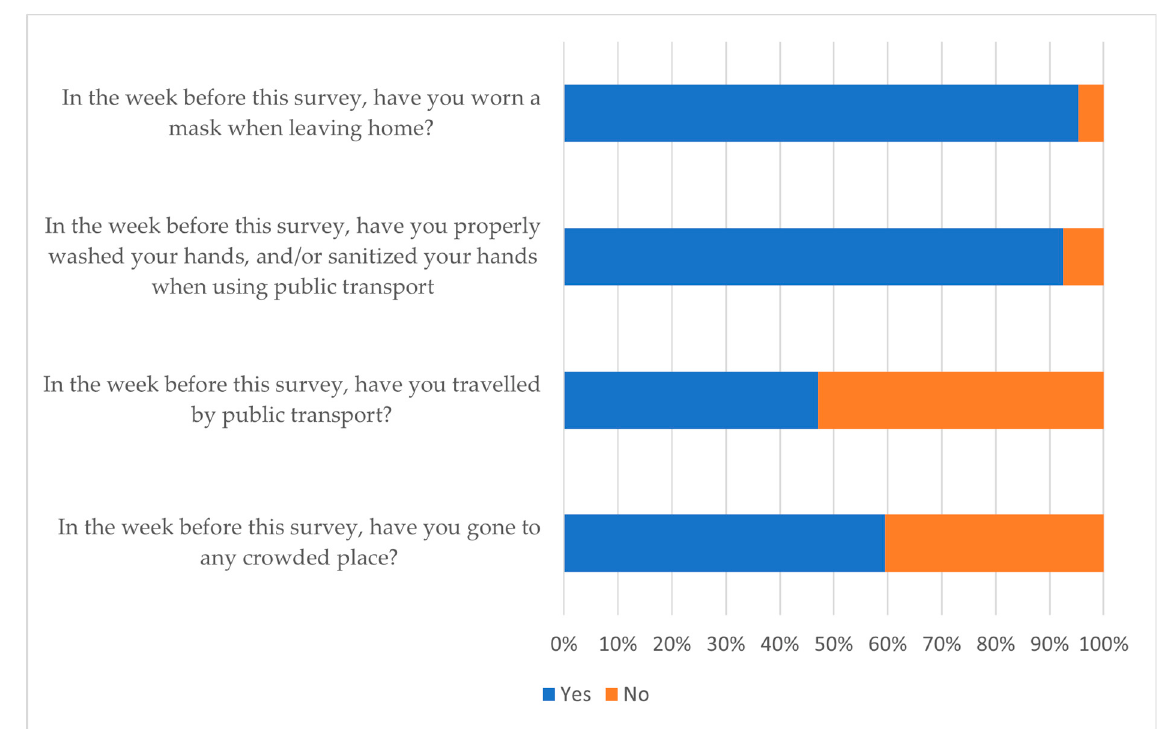
Figure 5. Practises of participants regarding COVID-19 (N = 1014).